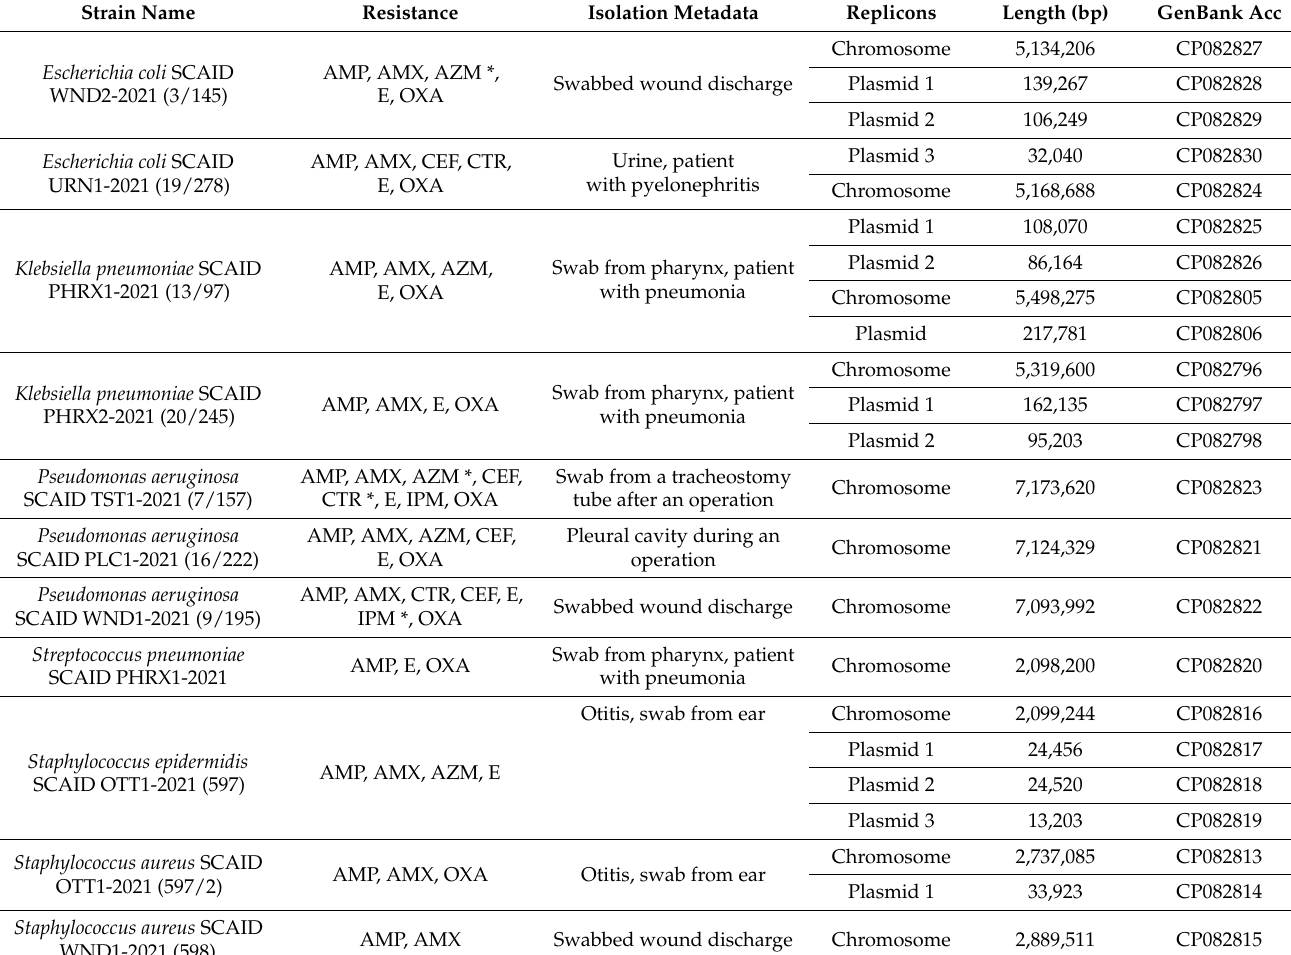
Table 1. Bacterial isolates used in this